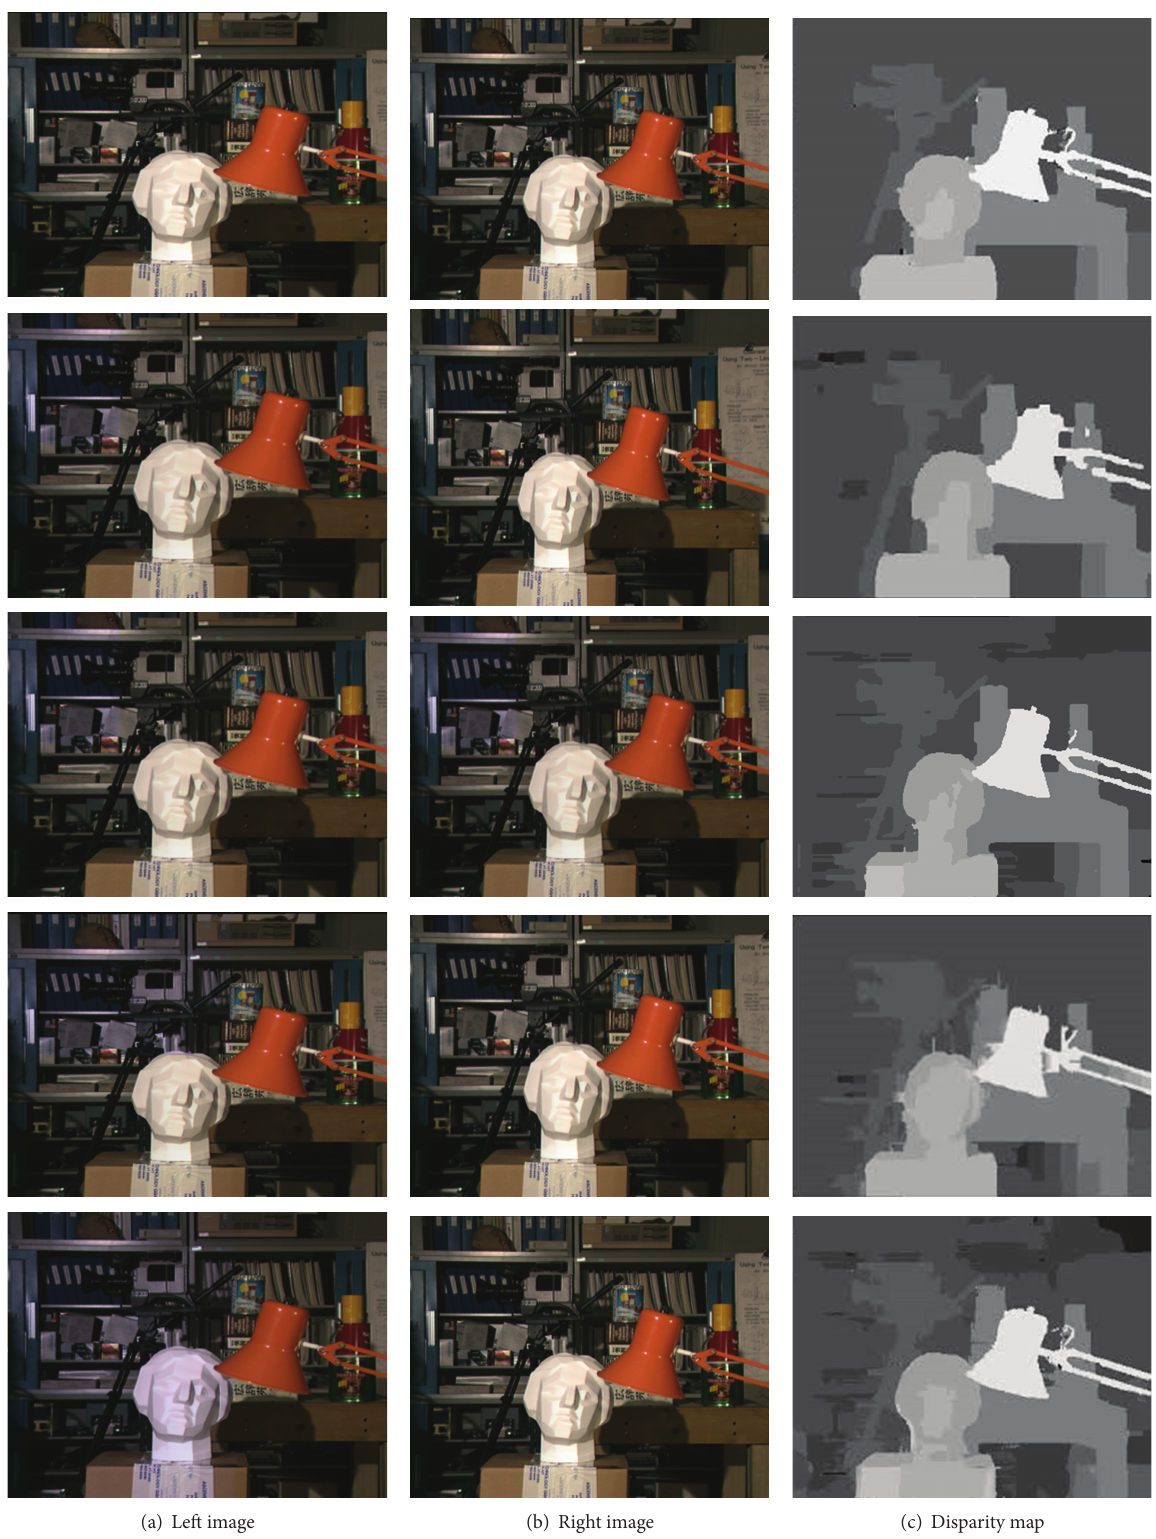
Figure 4: Disparity maps generated by our proposed algorithm for the Tsukuba dataset under 0% (first row), 6.25 % (second row), 12.50% (third row), 25% (fourth row), and 50% (fifth row) pixel illumination